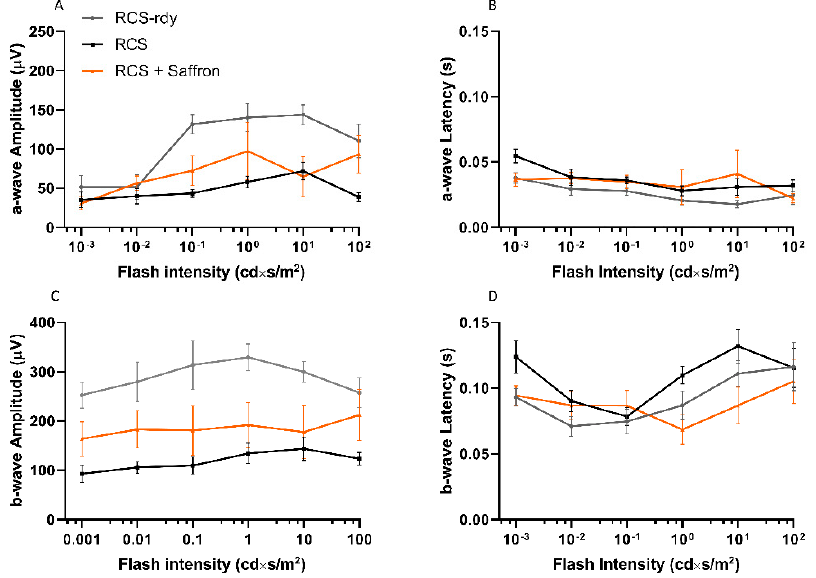
Figure 1. Impact of the Royal College of Surgeons Rat (RCS)Saffron treatment on the flash electroretinogram response. ( A – D ) Light dependent responses from P30 rats ( n = 9). No treatment-related significant differences were found in a- or b-wave amplitudes or in their related latencies. Neuroprotective properties of saffron seem to have been overcome by an extreme severity of this retinal dystrophy. (±SEM; Statistical tests two-way ANOVA followed by Dunnett’s test). Saffron treatment (1 mg/kg/day) does not appear to help in maintaining retinal func-